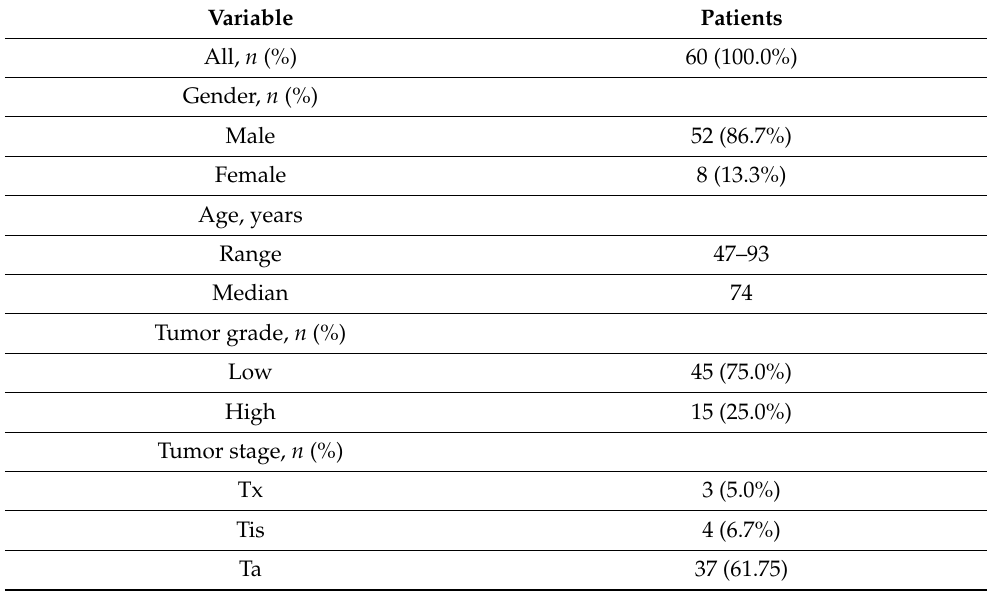
Table 1. The baseline clinico-pathologic characteristics in the prospective study of patients with